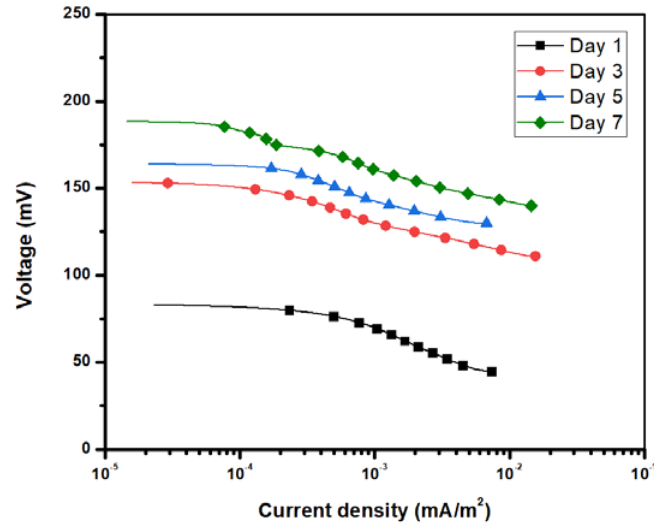
Figure 3. Potentiodynamic polarization curve (cathodic portion) of the MFC.